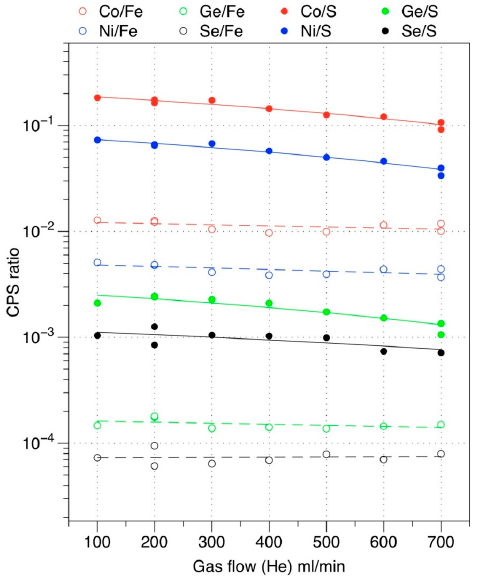
Figure 2. Plot showing variation in normalized CPS for Co, Ni, Ge and Se, using Fe and S as the internal standard, respectively. The analysis shown was conducted on a single crystal pyrite in spot mode. Carrier gas flow was changed to control the amount of ablated particles into the ICP-MS.